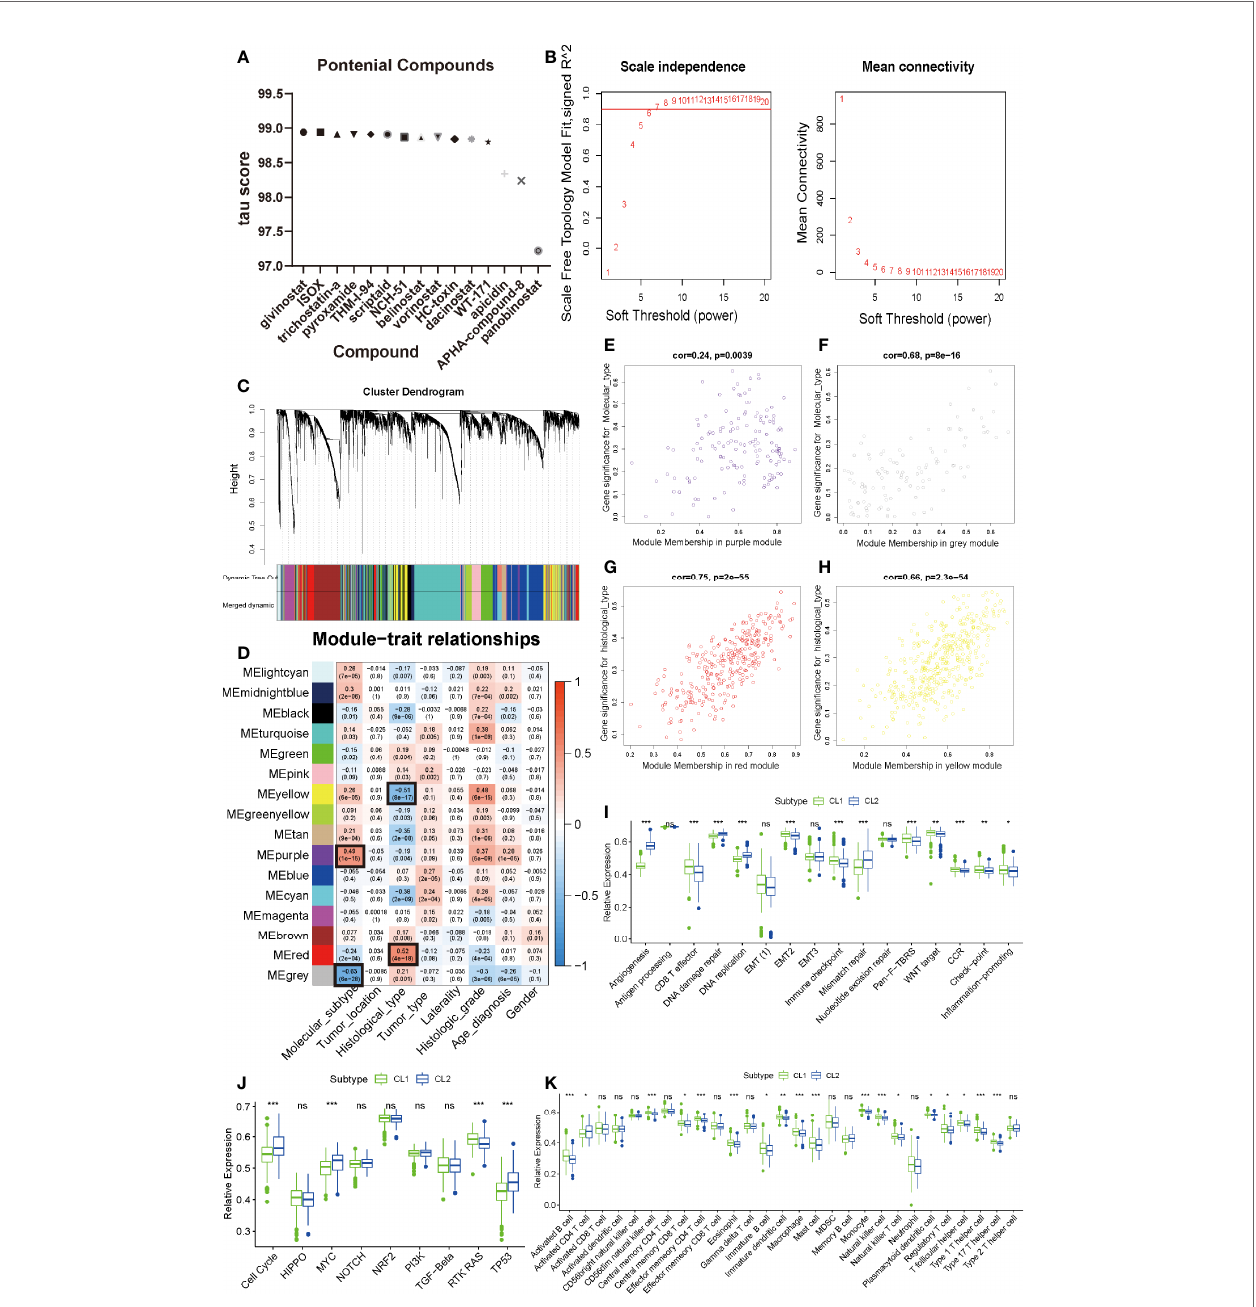
FIGURE 3 | Identi fi cation of meaningful modules and key genes. (A) Histogram of fourteen compounds shared the CMap mode-of-action of HDAC inhibitor, sorted by descending tau score of compounds. tau, connectivity score. (B) Determination of soft-thresholding power in weighted gene co-expression network analysis (WGCNA). (C) Hierarchical clustering dendrograms of identi fi ed co-expressed genes in modules in LGG. The branches of the cluster dendrogram correspond to the 10 different gene modules. Each leaf on the cluster dendrogram corresponds to a gene Each colored row represents a color-coded module which contains a group of highly connected genes. A total of 20 dynamic modules and 16 merged modules was identi fi ed in LGG respectively. (D) Correlations between the gene modules and clinical traits. The correlation coef fi cient in each cell represented the correlation between the gene module and the clinical traits, which decreased in size from red to blue. The corresponding P-value is also annotated. (E – H) Scatter plot of module eigengenes in the MEpurple module with molecular subtype (E) , a MEgrey module with molecular subtype (F) , a MEred module with histological type (G) , a MEyellow module with histological type (H) . Cor was the coef fi cient indices and p was Pearson ’ s correlation. (I – K) The enrichment differences of typical biological processes (I) , oncogenic pathways (J) and immune cell in fi ltration abundance (K) between CL1 and CL2. The upper and lower ends of the boxes represented an interquartile range of values. The lines in the boxes represented the median value, and the dots showed outliers. The asterisks represented the statistical P-value ( ∗ P <0.05; ∗∗ P <0.01; ∗∗∗ P <0.001, ns, no signi fi